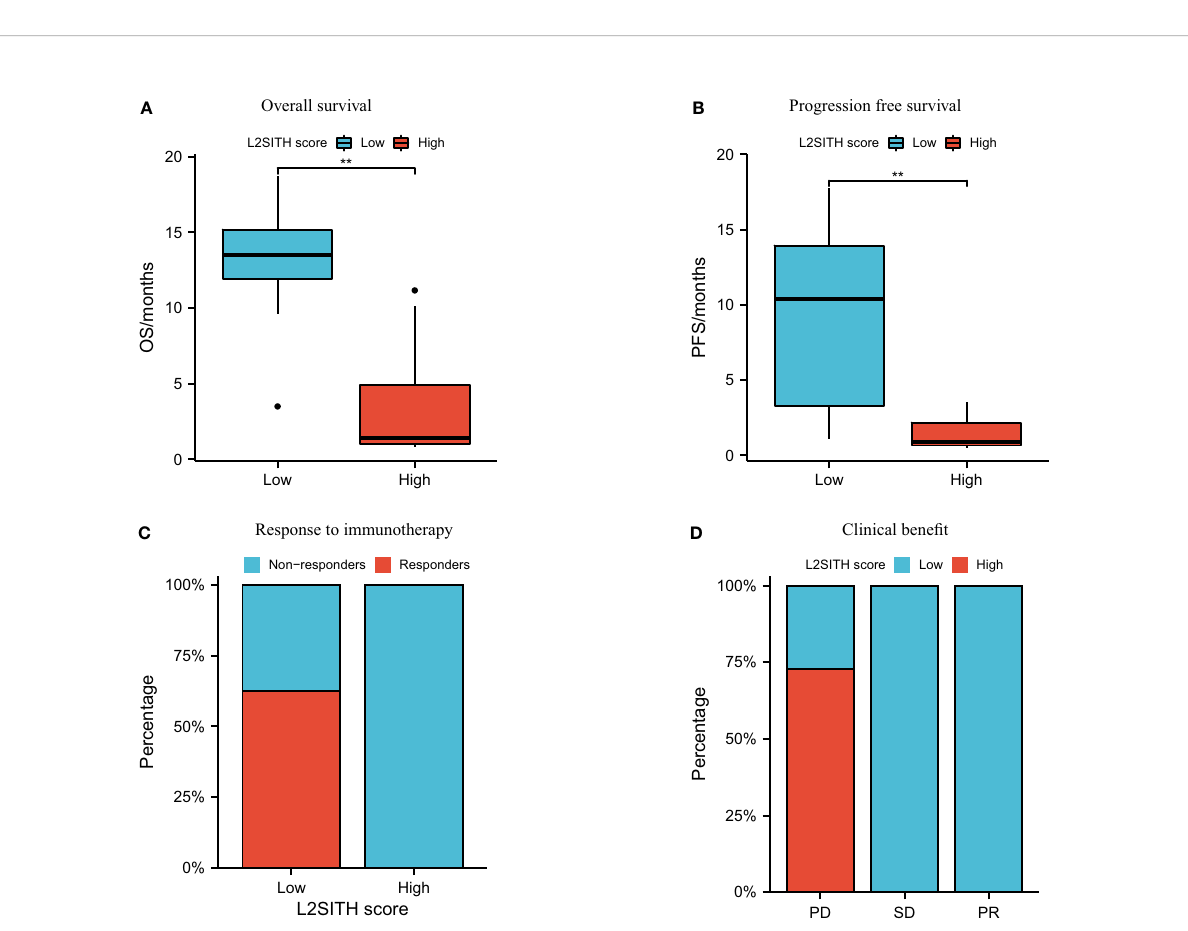
FIGURE 8 Survival and clinical response to anti – PD-1 inhibitor (Nivolumab) of high- and low-L2SITH score groups. (A) Overall survival of patients in high- and low-scored groups. (B) Progression-free survival of patients in high- and low-scored groups. (C) Percentage of patients with response to Nivolumab high- and low-scored groups. (D) Percentage of high- and low-scored patients with clinical response from Nivolumab, including progressive disease (PD), stable disease (SD), and partial response (PR). The symbol ** indicates signi fi cant difference at the 0.01 level